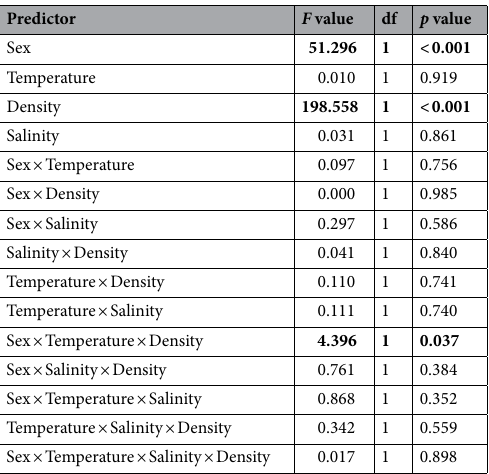
Table 1. Terms from generalised linear model with a quasibinomial error distribution after Type III analysis of deviance, to determine differences in Mytilus edulis prey consumption rates by Hemigrapsus takanoi according to “Sex”,” Temperature”, “Density” and “Salinity”. Significant terms are in